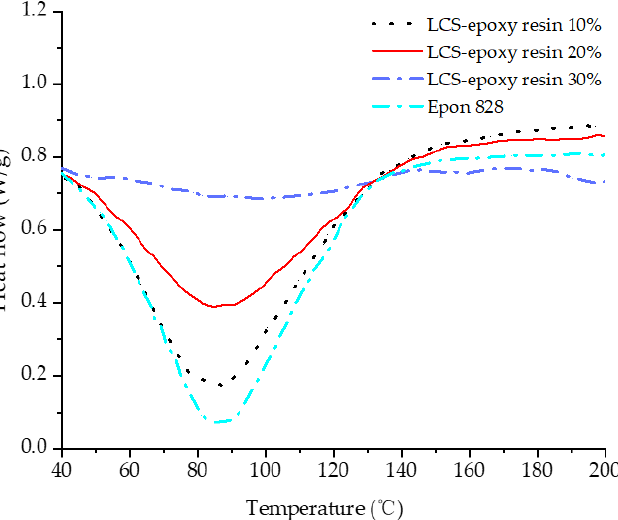
Figure 4. DSC curves of Epon 828 and Epon 828/cotton stalk-based-epoxy resin blends were ob- tained at the heating rate of 10